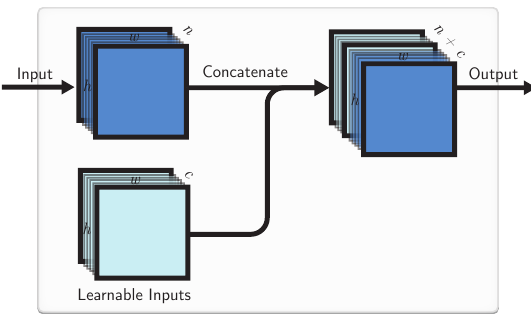
Figure 1. The proposed Learnable Input (LI) block. Each LI has the same spatial dimension as the original input. They are concatenated to the external input and passed to the other layers of